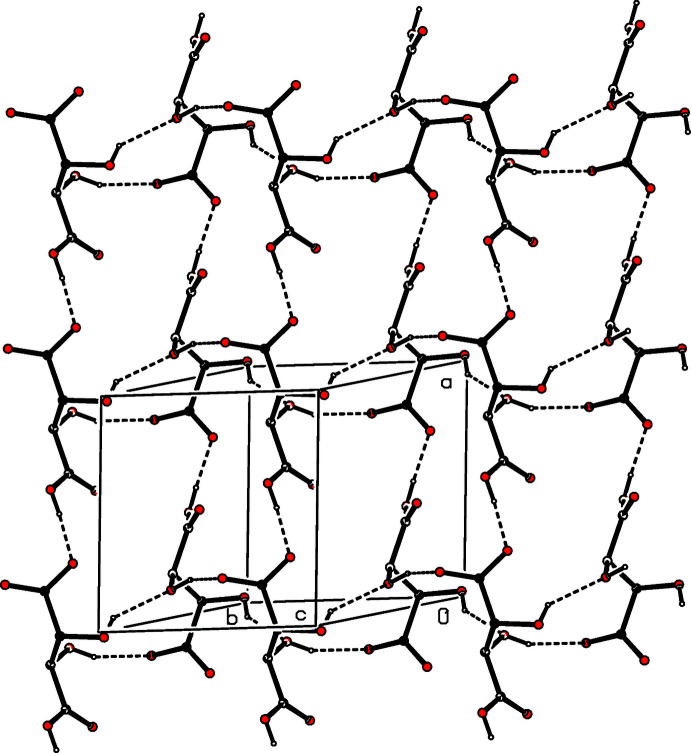
Part of the crystal structure of compound (XV) showing the formation of a hydrogen-bonded sheet of anions lying parallel to (001). Hydrogen bonds are drawn as dashed lines and, for the sake of clarity, the H atoms bonded to C atoms have been omitted.